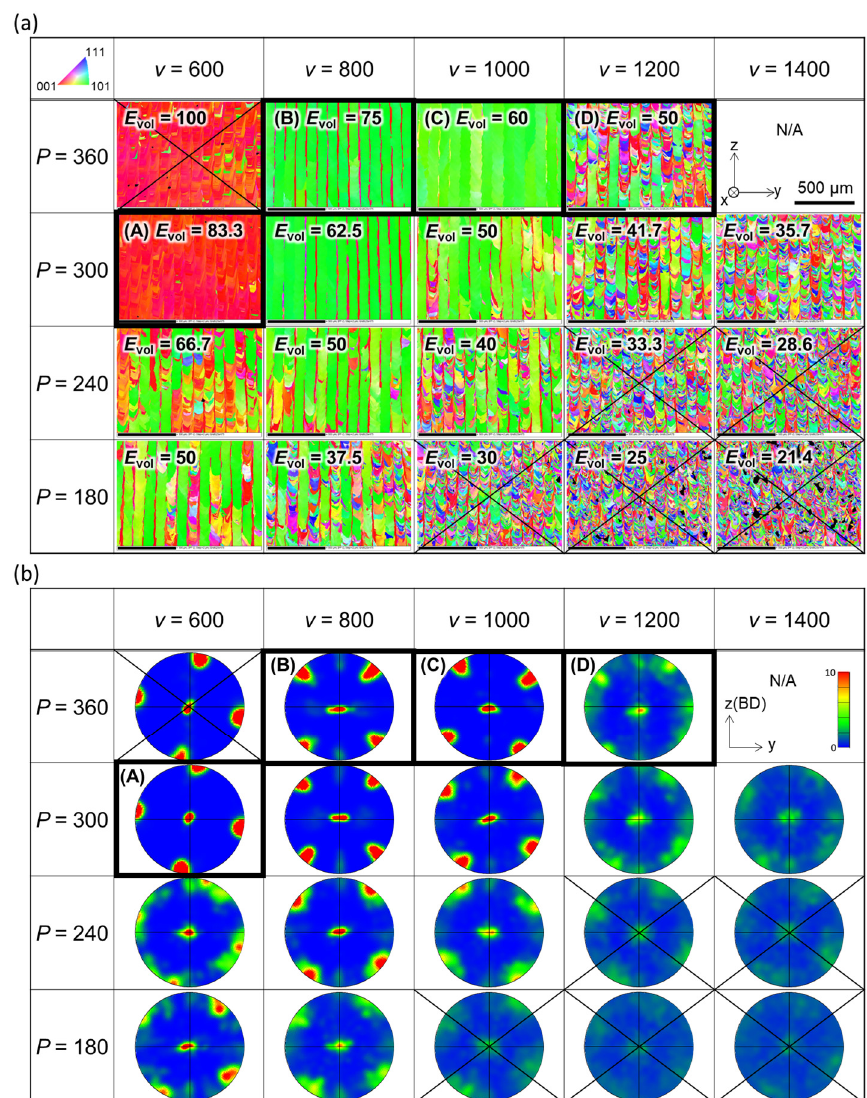
Figure 3. ( a ) IPF maps and ( b ) pole figures obtained for typical process parameters ( d = 0.10 mm for X-scan). The IPF maps are colorized according to the crystallographic orientation in the z direction. (A–D) shows the typical crystallographic textures, with (A) <100>-SCM, (B) CLM, (C) <110>-SCM, and (D) PCM.